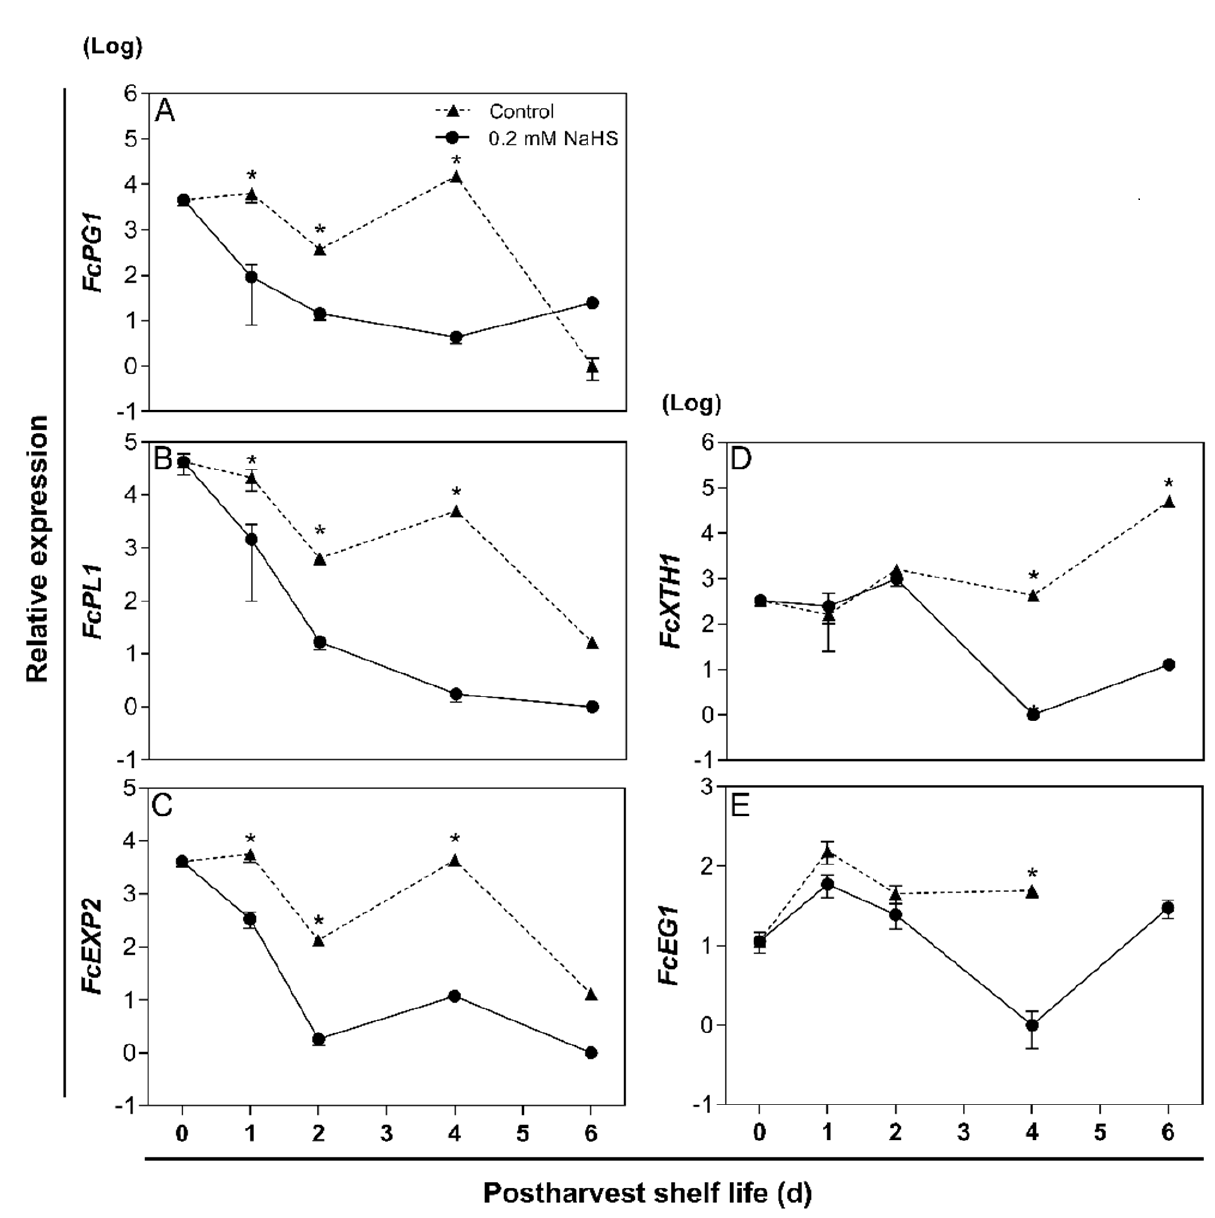
Figure 5. Effects of H 2 S treatment on the expression of cell wall disassembly- and remodeling-related key genes during postharvest shelf-life of Chilean strawberry ( Fragaria chiloensis ) fruit. Strawberries were treated after harvest with 0.2 mM H 2 S donor NaHS and maintained under storage at 20 ◦ C for up to 6 d. Sampling was performed at harvest (0 d) and after 2, 4 and 6 days. Gene expression profile of ( A ) polygalacturonase 1 ( FcPG1 ); ( B ) pectate lyase 1 ( FcPL1 ); ( C ) expansin 2 ( FcEXP2 ); ( D ) xyloglucan transglycosylase-hydrolase 1 ( FcXTH1 ), and ( E ) endo- β -1,4-glucanase 1 ( FcEG1 ). The data were analyzed by Tukey test ( p < 0.05) per time. Each value represents mean ± SD ( n = 4). Asterisks indicate significant differences between treatments. For details, see Section 4.